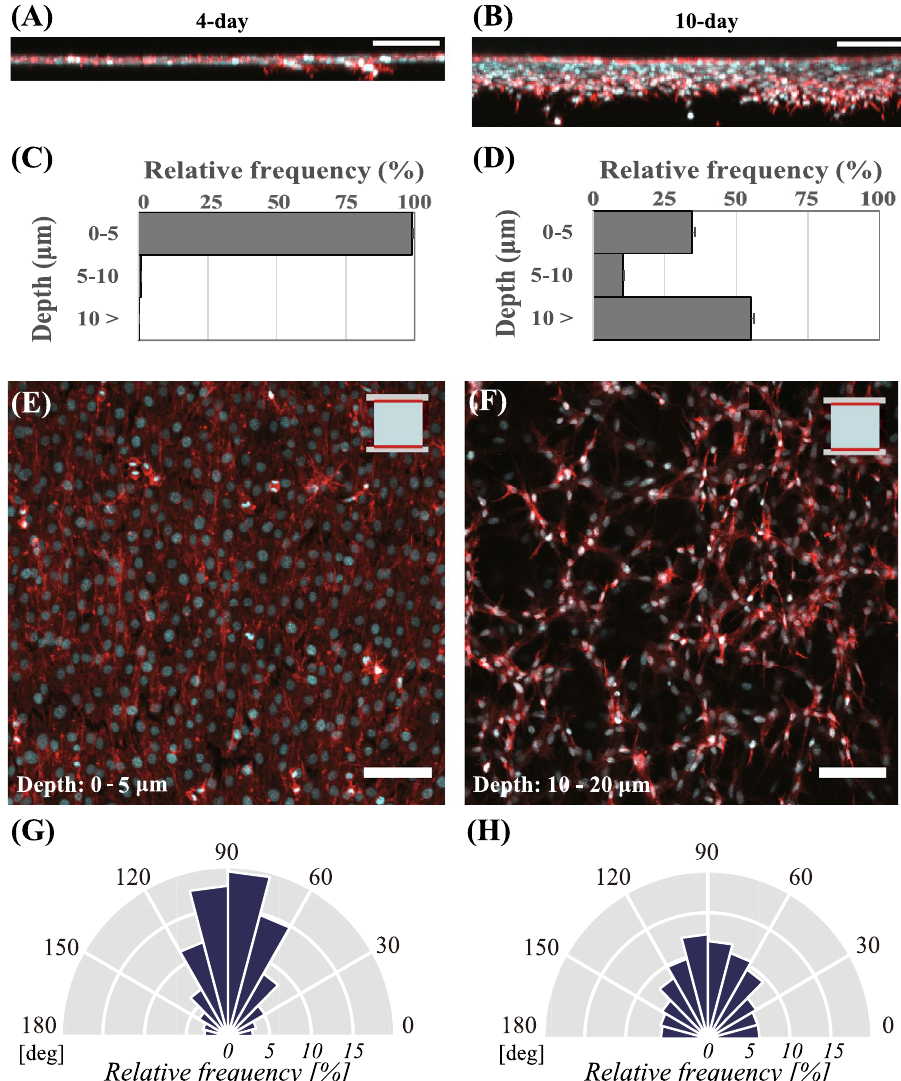
Figure 2. Image of DAPI and ACTIN staining in the vertical-section of cells subcultured in the 2-side fixed matrix after ( A ) 4-days and ( B ) 10-days incubation. Migrated cellular populations of osteoblast-like cells depending on the depth of the 2-side fixed collagen matrix at 0–5, 5–10, and 10 µm or deeper after ( C ) 4-days and ( D ) 10-days incubation. Bars represent the mean ± standard error. Image of DAPI and ACTIN staining depicting the cellular morphology ( E ) on the surface of the matrix at 0–5 µm depth after 4 days incubation and ( F ) at 10–20 µm depth inside the matrix after 10 days incubation. Ratio of cellular alignment ( G ) on the surface of the matrix after 4 days incubation and ( H ) at 10–20 µm depth in the matrix after 10 days incubation. Scale bars = 100